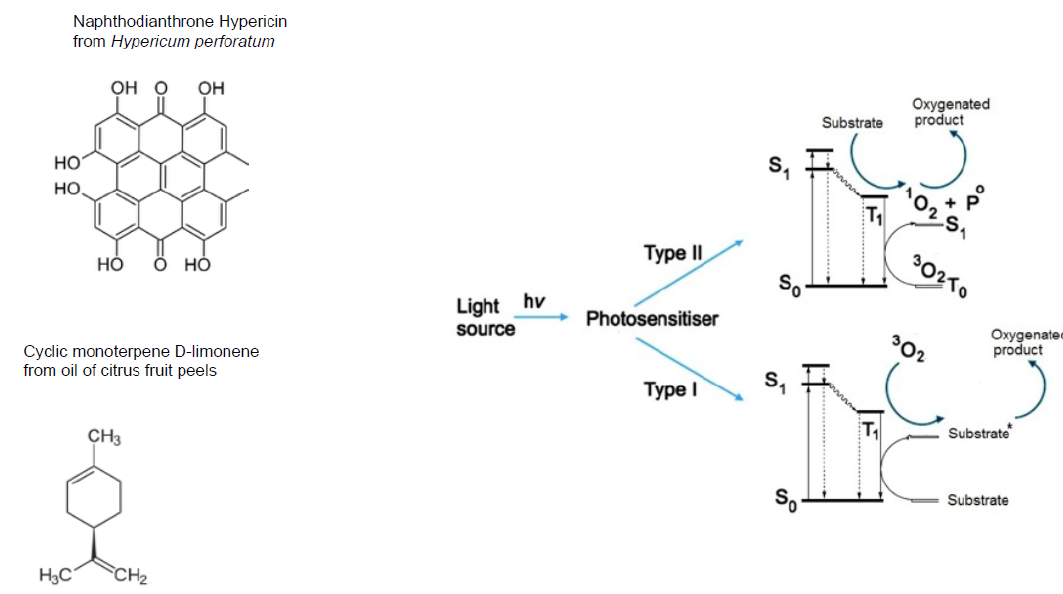
Figure 4. Excitation of photo-sensitisers. Scheme explaining the process of solar light (UV, visible, infrared) -excitation of secondary plant metabolites followed by photo-chemical reactions.